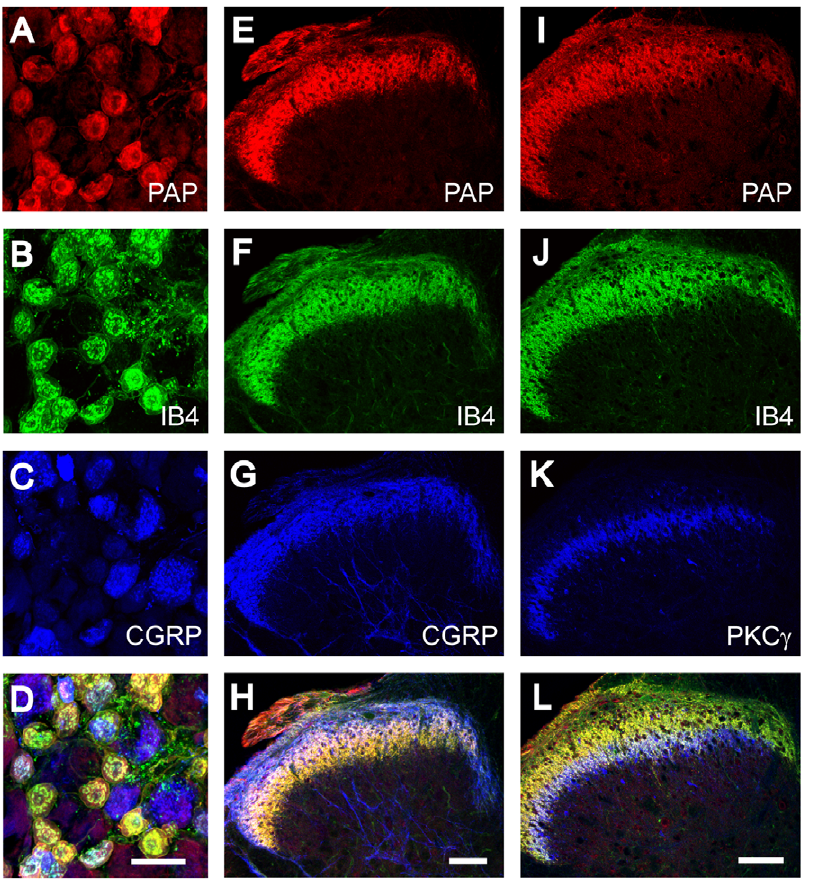
Figure 3. Chicken antibody detects PAP in rat DRG neurons and dorsal spinal cord. (A–D) Sections from rat L4-L6 DRG and (E–L) lumbar spinal cord were stained with chicken anti-PAP antibodies (red) and with antibodies against various sensory neuron markers and spinal interneuron marker PKC c (blue, green). (D, H, L) Merged images. All images were acquired by confocal microscopy. Scale bar in (D) 50 m m, (H) 100 m m.